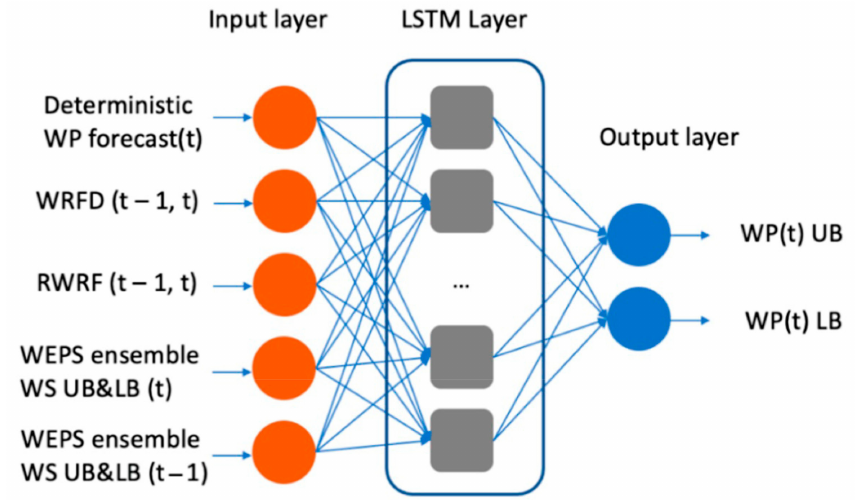
Figure 10. Proposed three-hour-ahead probabilistic forecasting model.